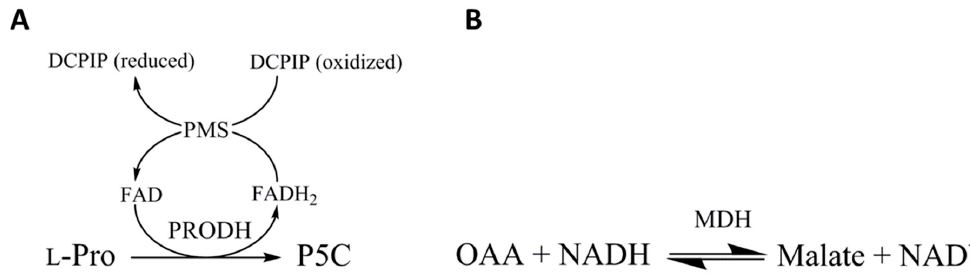
Figure 2. Enzymatic activities of proline dehydrogenase (PRODH) and malate dehydrogenase (MDH). The enzymatic activities were monitored by spectrometry by measuring the absorbance (OD) at 600 nm and 340 nm,